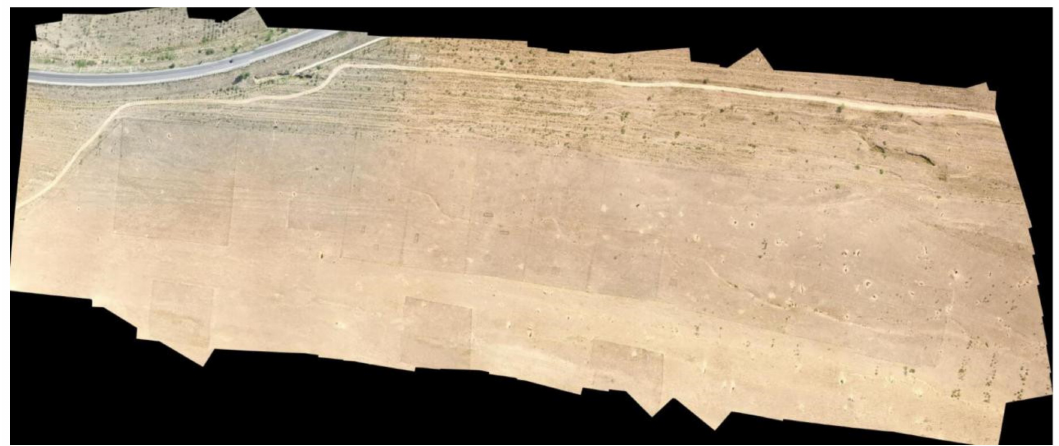
Figure 3. Georeferenced orthomosaic of the study